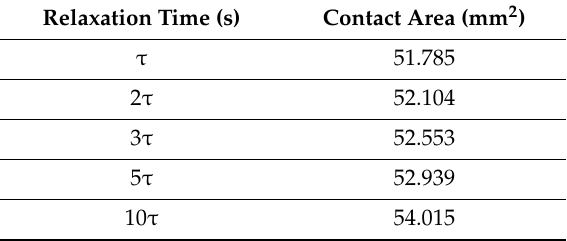
Table 2. Measured contact area under di ff erent